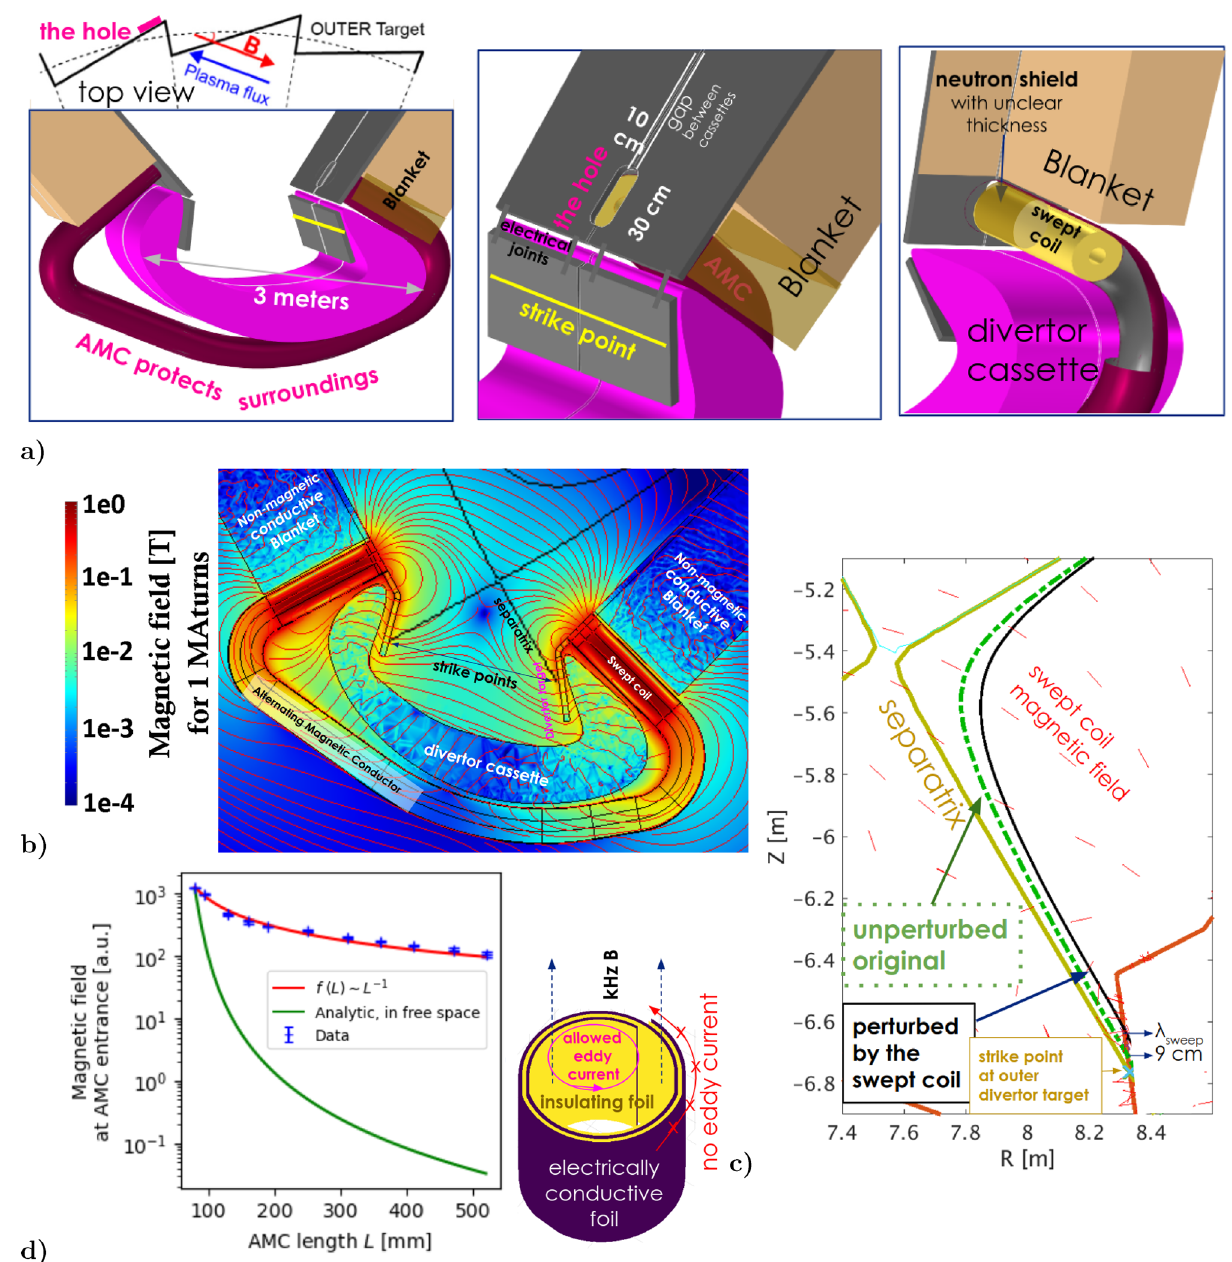
Figure 4. ( a ) Halves of two neighbouring heat shield DEMO divertor cassettes from Fig. 1 bottom with the hole in between, magnetically shielded by fish-scale toroidal shaping (sketched on top left, according to 47 ). AMC is connected to the divertor cassette, nested into the blanket module. The vertical electrical joints stop the AC magnetic field from returning back to the coil. The bottom part of AMC is unnecessary (its removal does not significantly change the desired influence on the plasma), serves only to protect the surrounding diagnostics from the kHz B-field. The simulation shows that 2 cm toroidal gaps between the heavy cassettes (as on ITER 48 due to engineering reasons) and 2 mm cuts in AMC (feasible as it’s a light tube) yields the strongest magnetic field penetration into the plasma. ( b ) COMSOL Multiphysics calculated magnetic field lines (for 1.6 kHz) penetrating through the divertor cassette hole. The induced eddy currents in the divertor targets and AMC stop its magnetic field returning straight back to the solenoid further end, thus penetrating deeper into the plasma. ( c ) Poloidal cross-section of a magnetic field line passing through the divertor region. Plasma progressively deviates outwards while flying through each swept coil (each with the 9 cm above 1 MegaAmperTurns), such that the strike point integrated shift is (cid:31) swp maximum N turns I coil = = 0 ) (thin) line. For I coil , the shift is the same in opposite direction. Field lines outside the unperturbed ( I coil = − the strike point shift by a similar distance. ( d ) Experimental profile of magnetic field B along coil axis inside the Alternating Magnetic Conductor. Sketched on right, the AMC shows L − 1 decay with distance, whilst in free space far away from the coil it decays as L − 3 49